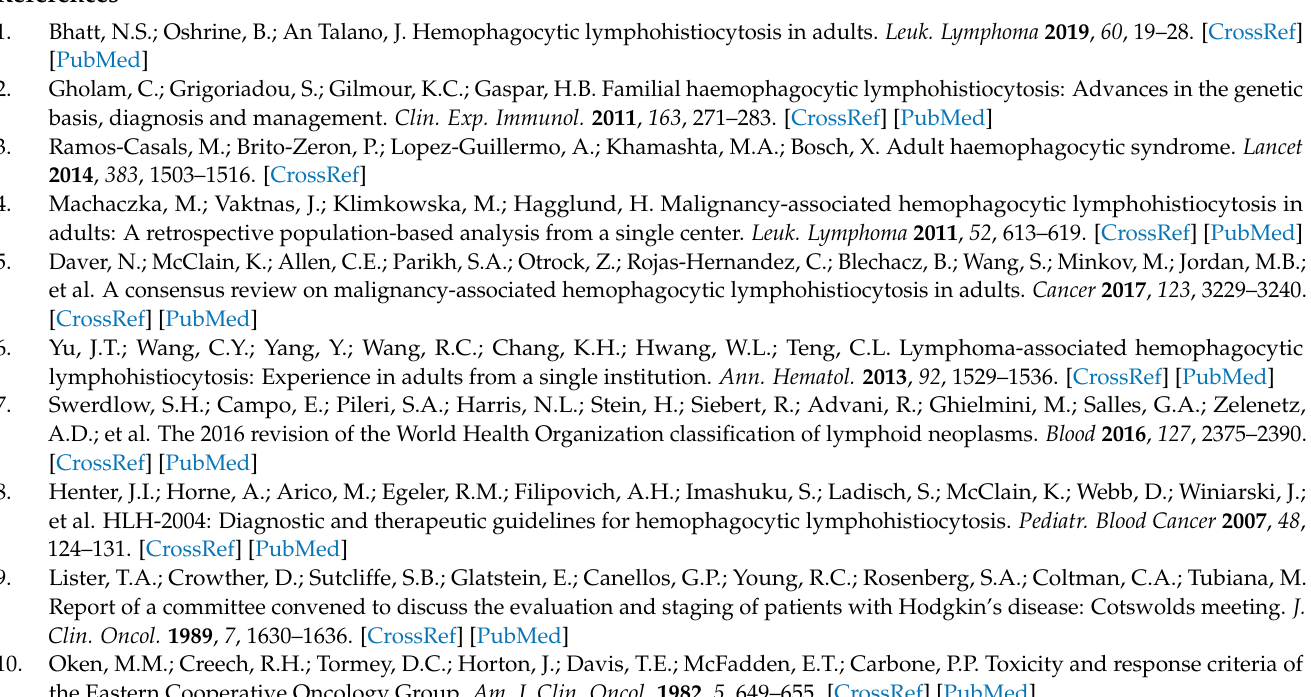
HSCT. Supplemental Table S2: Chemotherapy regimen comparisons among HLH patients diagnosed between 2004–2012 and 2013–2021. Supplemental Figure S1: Therapeutic algorithm of